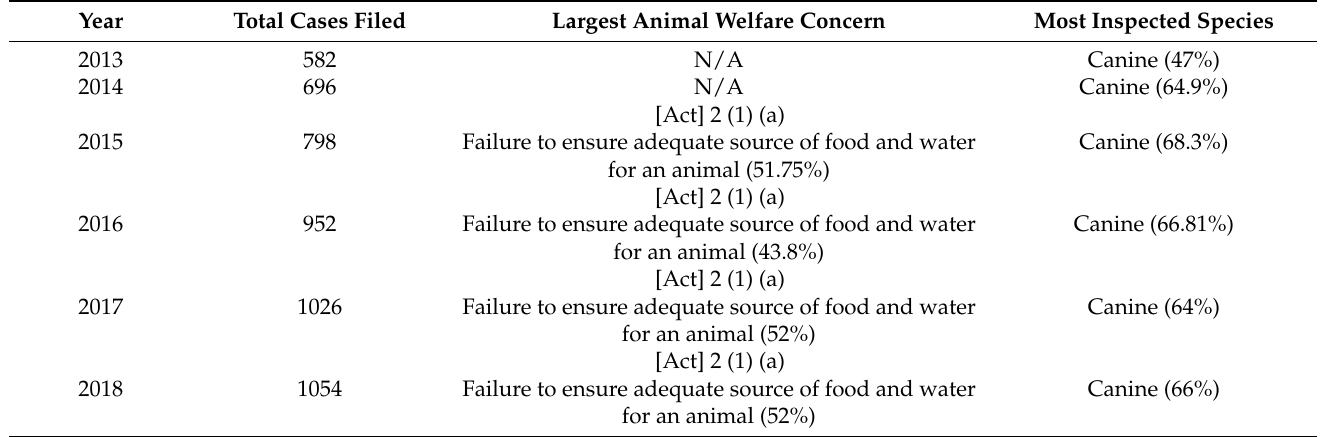
Table 5. Investigations Details from Manitoba. Data provided by the Ministry of Agriculture (Campbell 2019; Coulter and Campbell 2020).